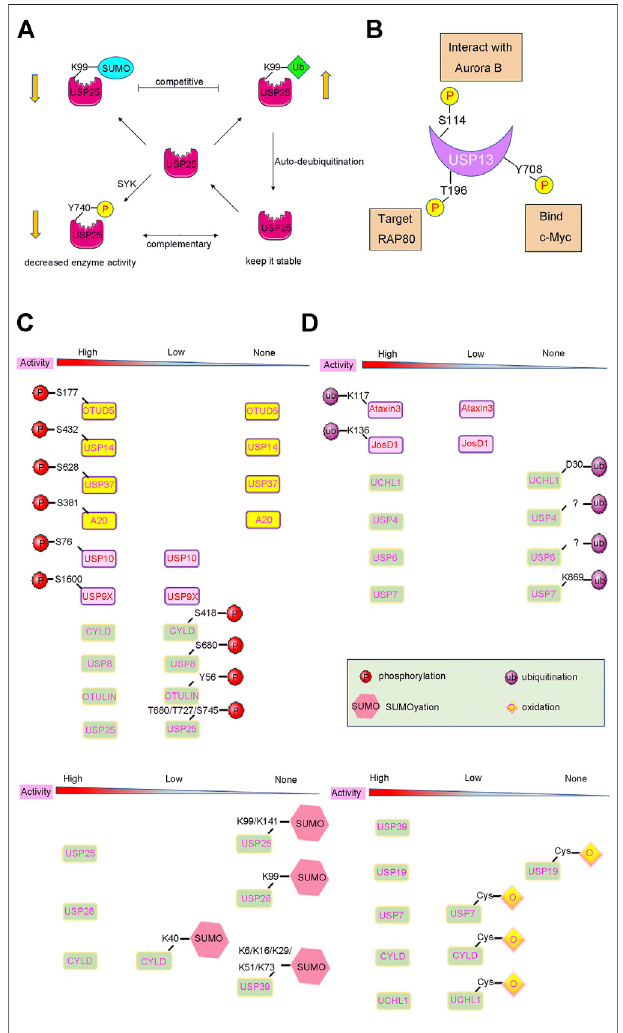
FIGURE 3 | PTMs induced activity changes of DUBs. (A) Complex crosstalks of different PTMs often occur on DUBs with different effects. For example, USP25 can be modi fi ed by phosphorylation, SUMOylation and ubiquitination, which affect the activity and stability of USP25. (B) Many DUBs undergo one or more PTMs, such as USP13 can be phosphorylated at Ser114, Thr196, Tyr708, leading to different biological events. (C) and (D) DUB activities can also be changed by PTMs such as phosphorylation, ubiquitylation, and SUMOylation. The arrow below shows the change in DUBs ’ enzyme activity after PTMs modi fi